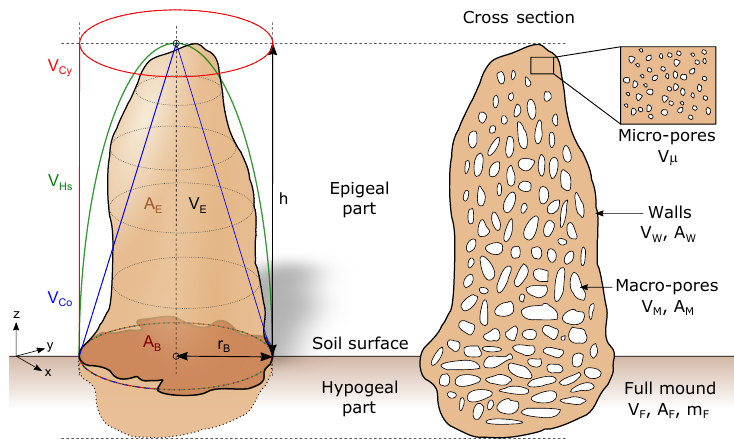
Figure 1. Illustration of external and internal surface and volume fractions of a termite mound (TM). V E : epigeal volume; A E ; epigeal surface area; A B ; basal area (intersection of the TM with the soil surface); r B : radius of a hypothetical circle with a circumference equal to A B ; h : epigeal height; V Cy , V Hs , V Co : volume of a hypothetical cylinder, hemi-spheroid and cone, respectively, used to approximate V E based on r B and h ; V µ : volume of micro-pores in the wall material; V W : volume of the wall material; A W : area of wall material in a cross section; V M : volume of macro-pores (all cavities large enough for termites; generally referred to as “chambers”); A M : area of macro-pores in a cross section; V F : full mound volume including all pores and hypogeal parts; A F : area of the full mound in a cross section; m F : mass of the full